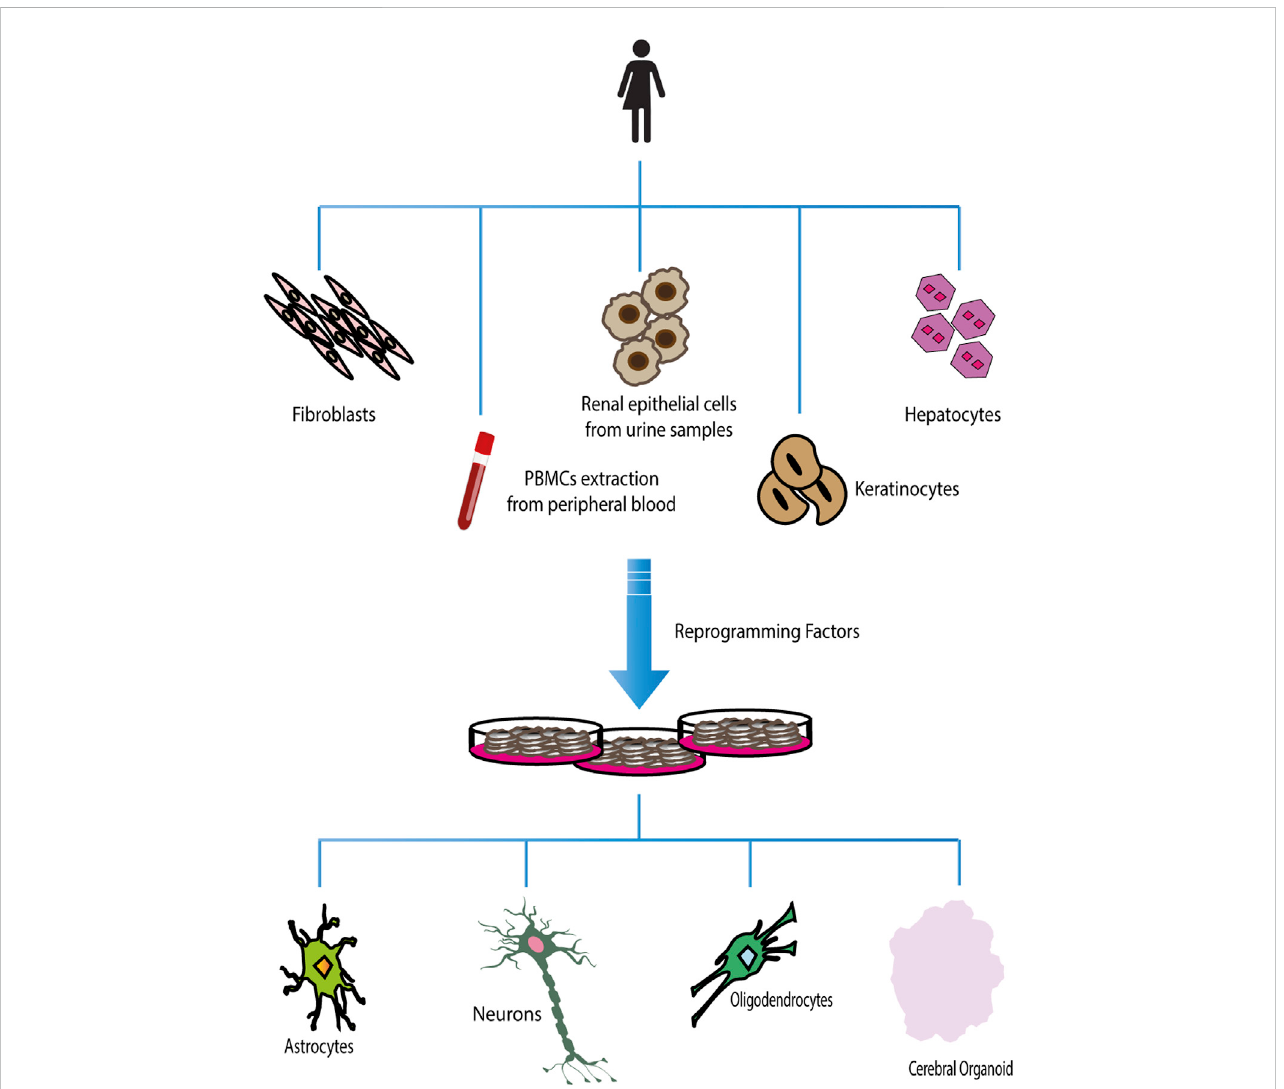
Reprogramming and differentiation of hiPSCs. Different adult somatic cells can be reprogrammed in induced Pluripotent Stem Cells. Once hiPSCs have been obtained, they can be used to generate all types of terminally differentiated